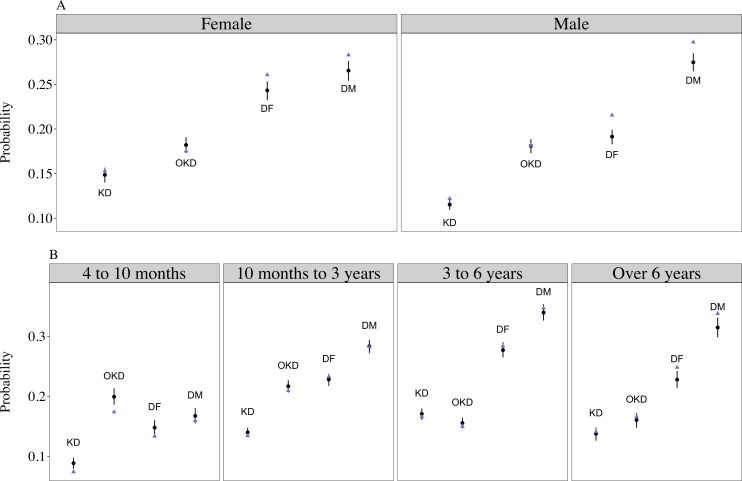
Predicted probabilities of aggression towards dogs in different contexts by sex (panel A) and age groups (panel B).Black points and vertical lines show mean and 95% highest density intervals of model parameter estimates; blue triangles show raw sample data. Model estimates were obtained by marginalising over the random effects (see the Supporting Information). Abbreviations used in the figure: KD (In kennel towards dogs); OKD (Out of kennel towards dogs); DF (Interactions with female dogs); DM (Interactions with male dogs).